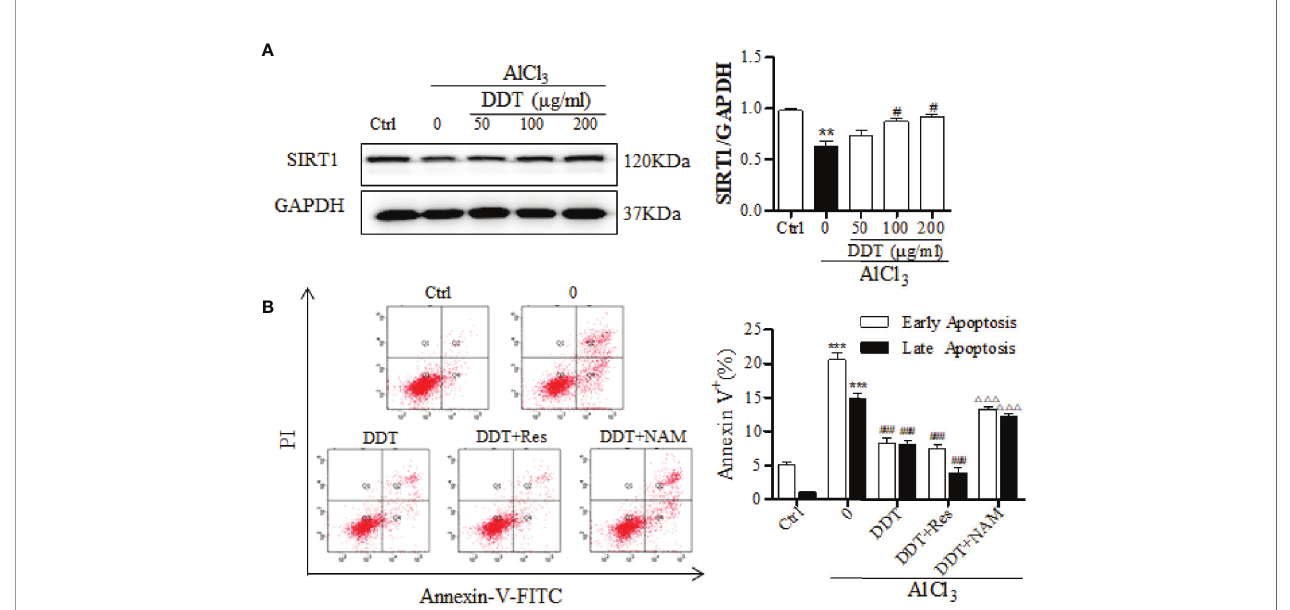
FIGURE 7 | DDT protects PC12 cell apoptosis from AlCl 3 by activating SIRT1. (A) After DDT treatment and AlCl 3 incubation for 48 h, the level of SIRT1 in PC12 cells was detected by western blot analysis. The intensity was normalized to the intensity of GAPDH and shown on the right. (B) PC12 cells were incubated with DDT and AlCl 3 for 48 h, and/or SIRT1 activator/inhibitor (resveratrol, Res, 10 m M for 24 h; nicotinamide, NAM, 10 mM for 16 h), and then collected to analyze the percentages of early and late apoptosis by fl ow cytometry analysis. Values are means ± standard derivation from three independent experiments. Ctrl: control group.